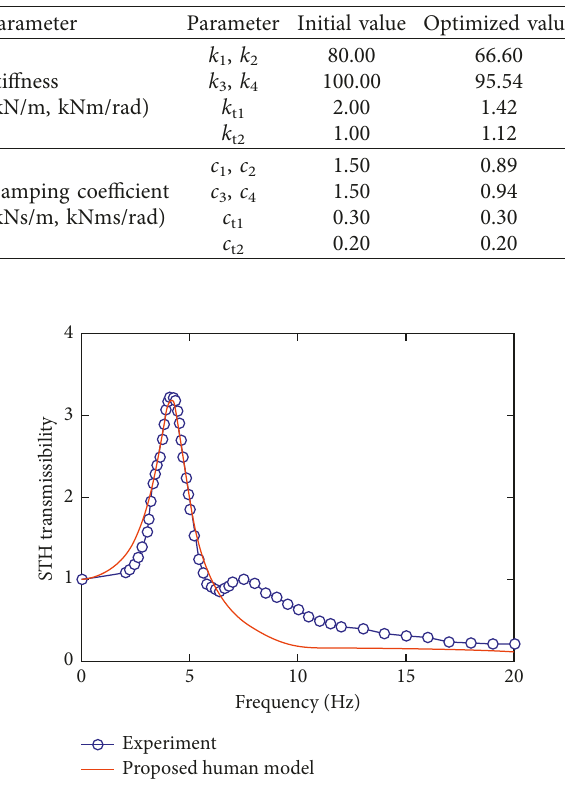
Figure 4: STH transmissibility of experimental results [30] and the five-degree-of-freedom human linear model calculated using the optimized stiffness and damping